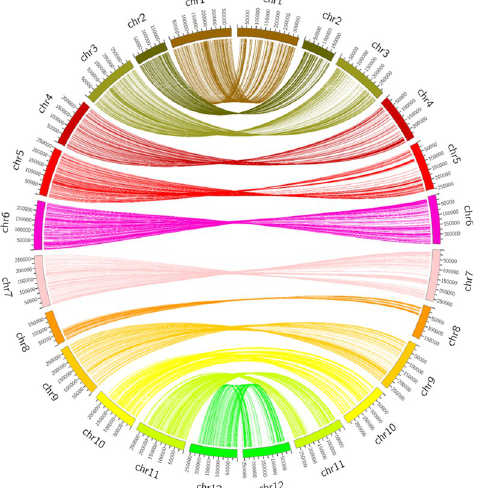
Fig 3. Collinearity between the genetic map and the physical map of pepper. The outer circle represents the total number of chromosomes (chr = ID) on left side and linkage groups (chr = ID) on right side; markers located within linkage groups are linked to the parallel position on chromosomes by different colored lines in the inner